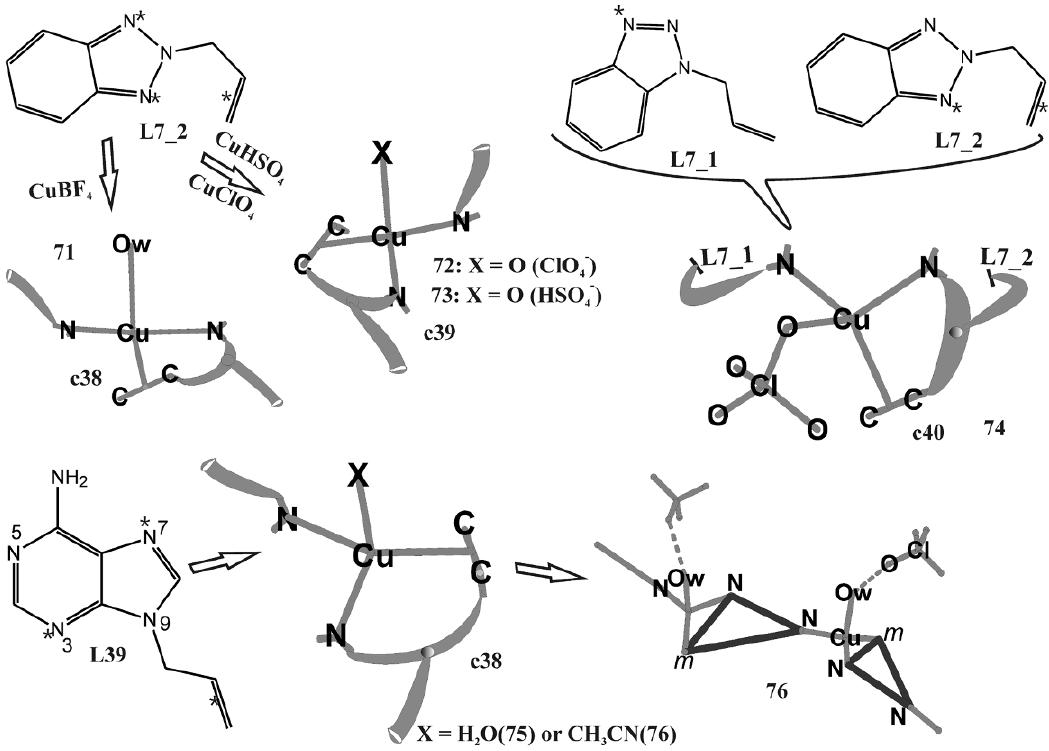
Figure 16. Structural genesis of C38-C40 fragments in 71-76